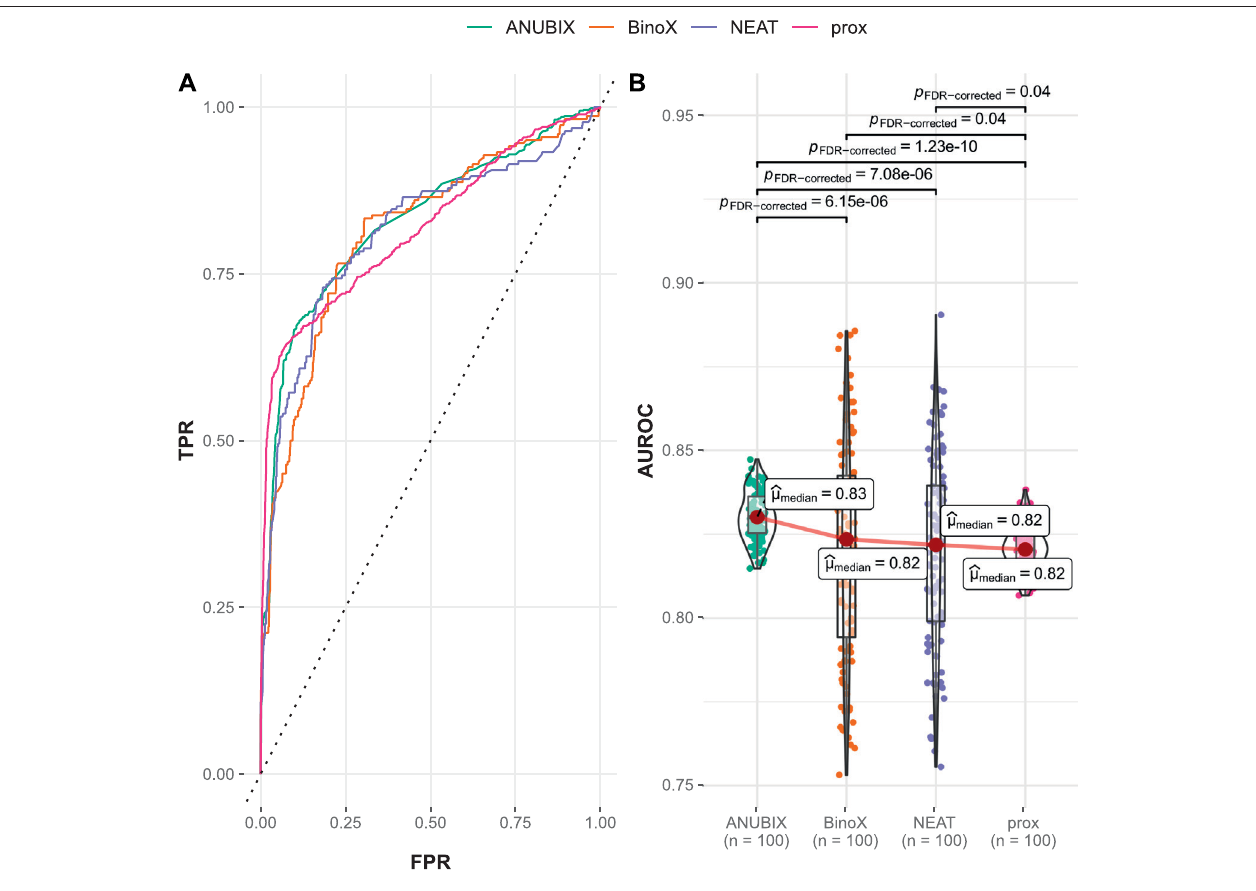
FIGURE 7 | Drug – drug similarity – based performance on the time-stamped benchmark. Performance of the different drug repurposing tools: ANUBIX (green), BinoX (orange), NEAT (purple), and proximity (prox, pink) on (A) ROC curves, where the dotted line represents random prediction, and (B) AUROC using sampled sets from the benchmark containing equal numbers of positive and negative drug – disease combinations. The pairwise Wilcoxon rank sum test was used to assess the signi fi cance of difference on AUROC. FDR-corrected p -values were obtained using the Benjamini – Hochberg procedure.